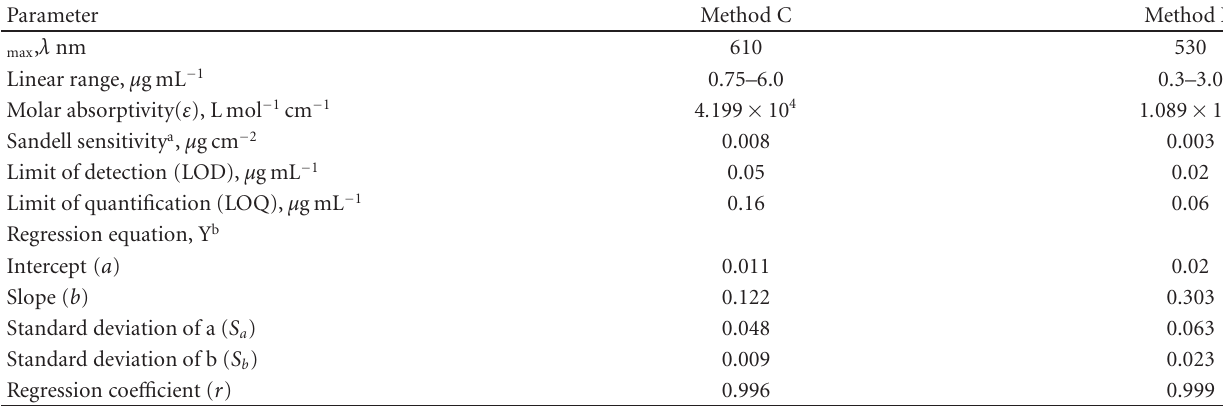
Table 2: Sensitivity and regression parameters.